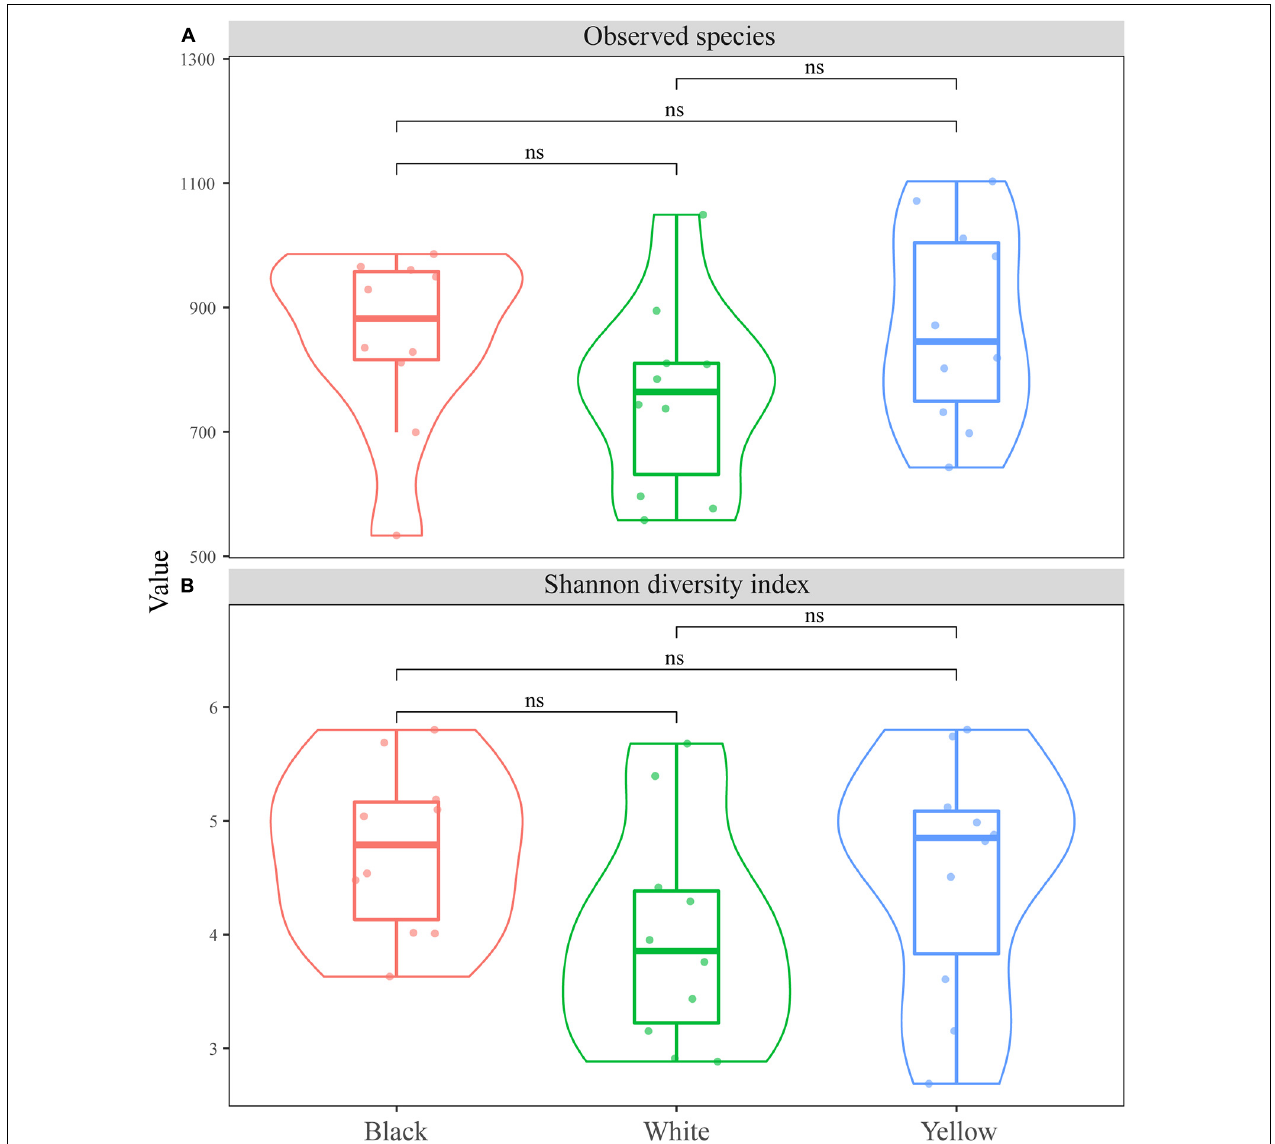
FIGURE 1 | Boxplots of α -diversity indexes. (A) Number of observed species; (B) Shannon diversity